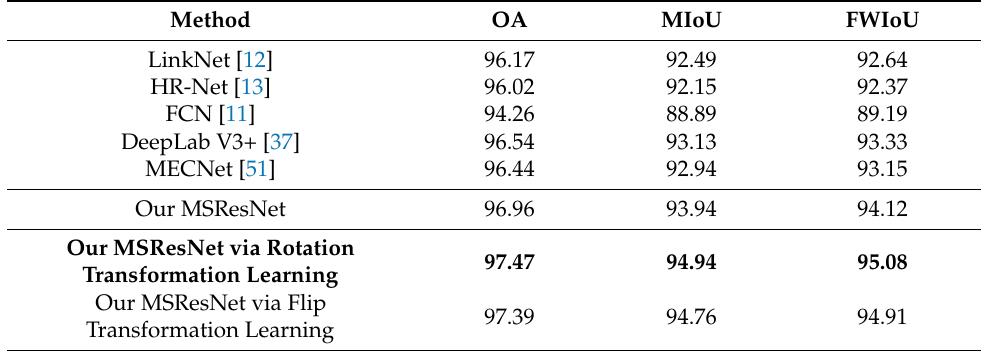
Table 5. Performances for the GID dataset